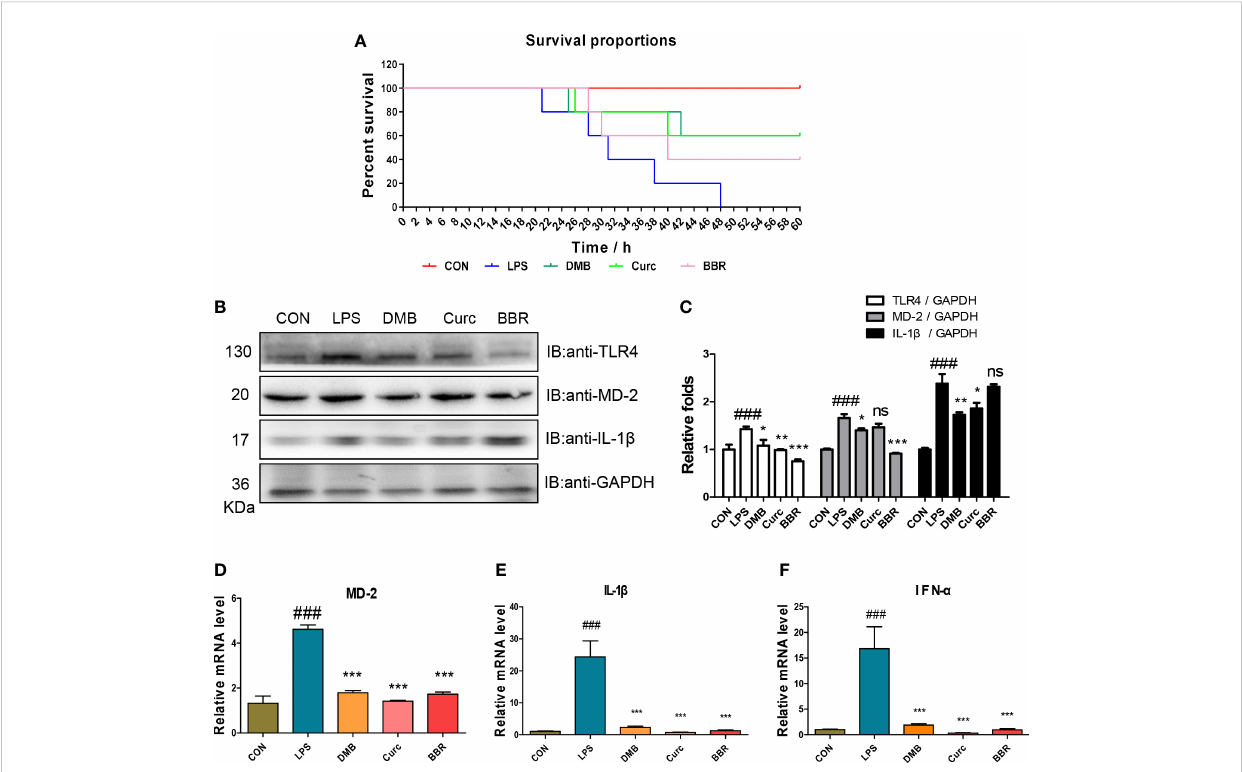
FIGURE 8 DMB ameliorated acute sepsis induced by LPS in mice. (A) The survival proportion of mice in different groups. (B) The protein expressions of TLR4, MD-2, and IL-1 b in colonic tissue. (C) The grayscale analysis of TLR4, MD-2, and IL-1 b in colonic tissue. (D – F) The mRNA level of MD-2, IL-1 b , and IFN- a in colonic tissue. Statistical analysis was performed using one-way ANOVA. n = 6. ### p < 0.001 (#: the LPS group versus the CON group) * p < 0.05, ** p < 0.01, *** p < 0.001, ns, non-signi fi cantly (*: the DMB, Curc, or BBR group versus the LPS